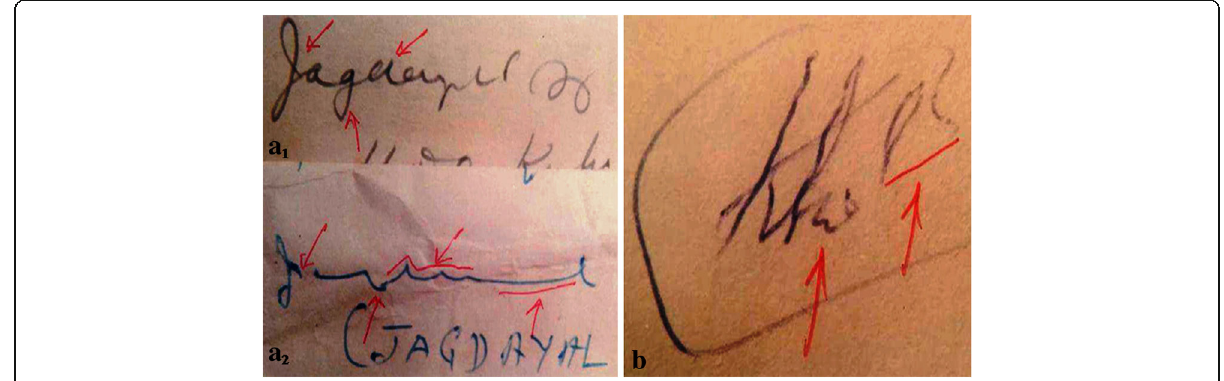
Fig. 3 Simplification/abbreviation. (a 1 ) Signature sample executed before the age of 60 years of a subject. (a 2 ) Signature sample showing simplification of letters as compared to old signature (a 1 ). (b) Signatures of a Parkinsonism patient showing abbreviations and simplifications of